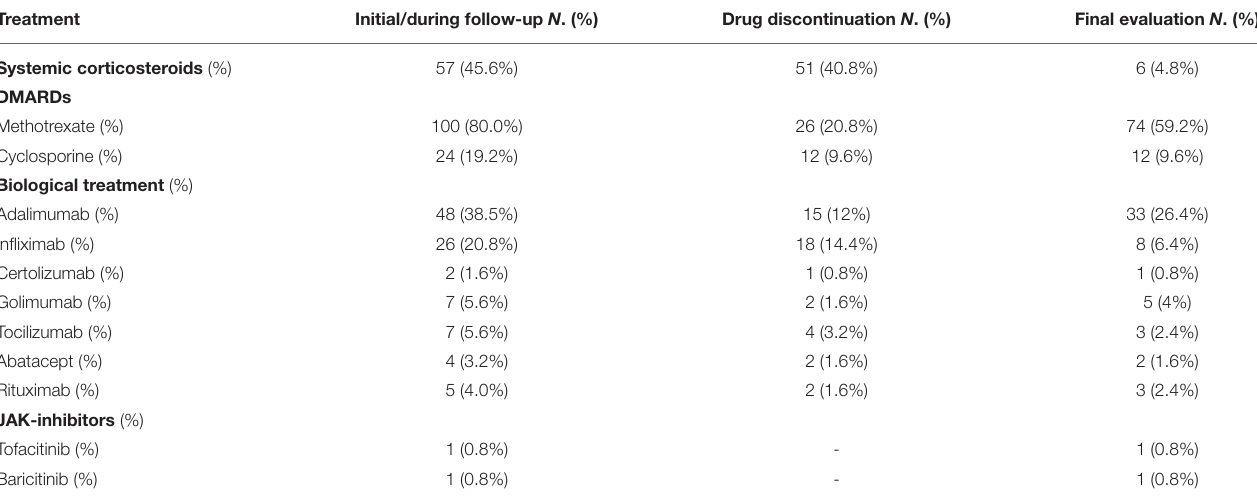
TABLE 2 | Systemic treatment at initial evaluation/during follow-up and at last evaluation. Treatment Initial/during follow-up N .